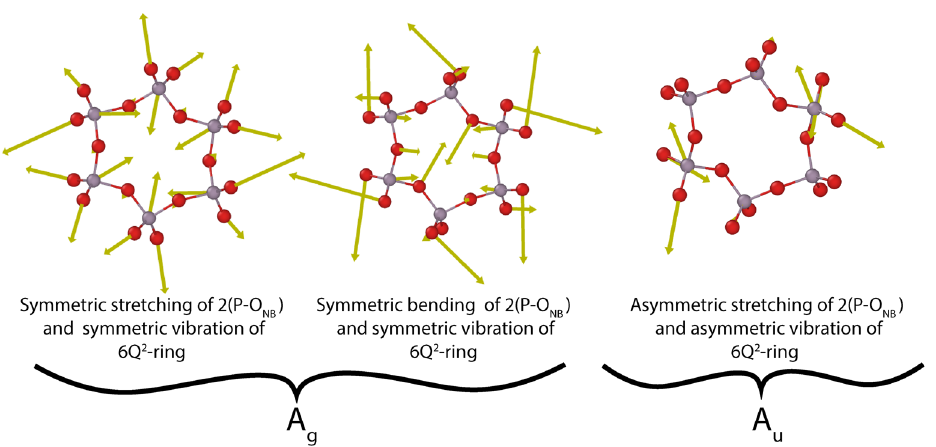
Figure 11. Examples of vibrations of 6Q 2 -ring in aluminum cyclohexaphosphate -Al(PO 3 ) 3